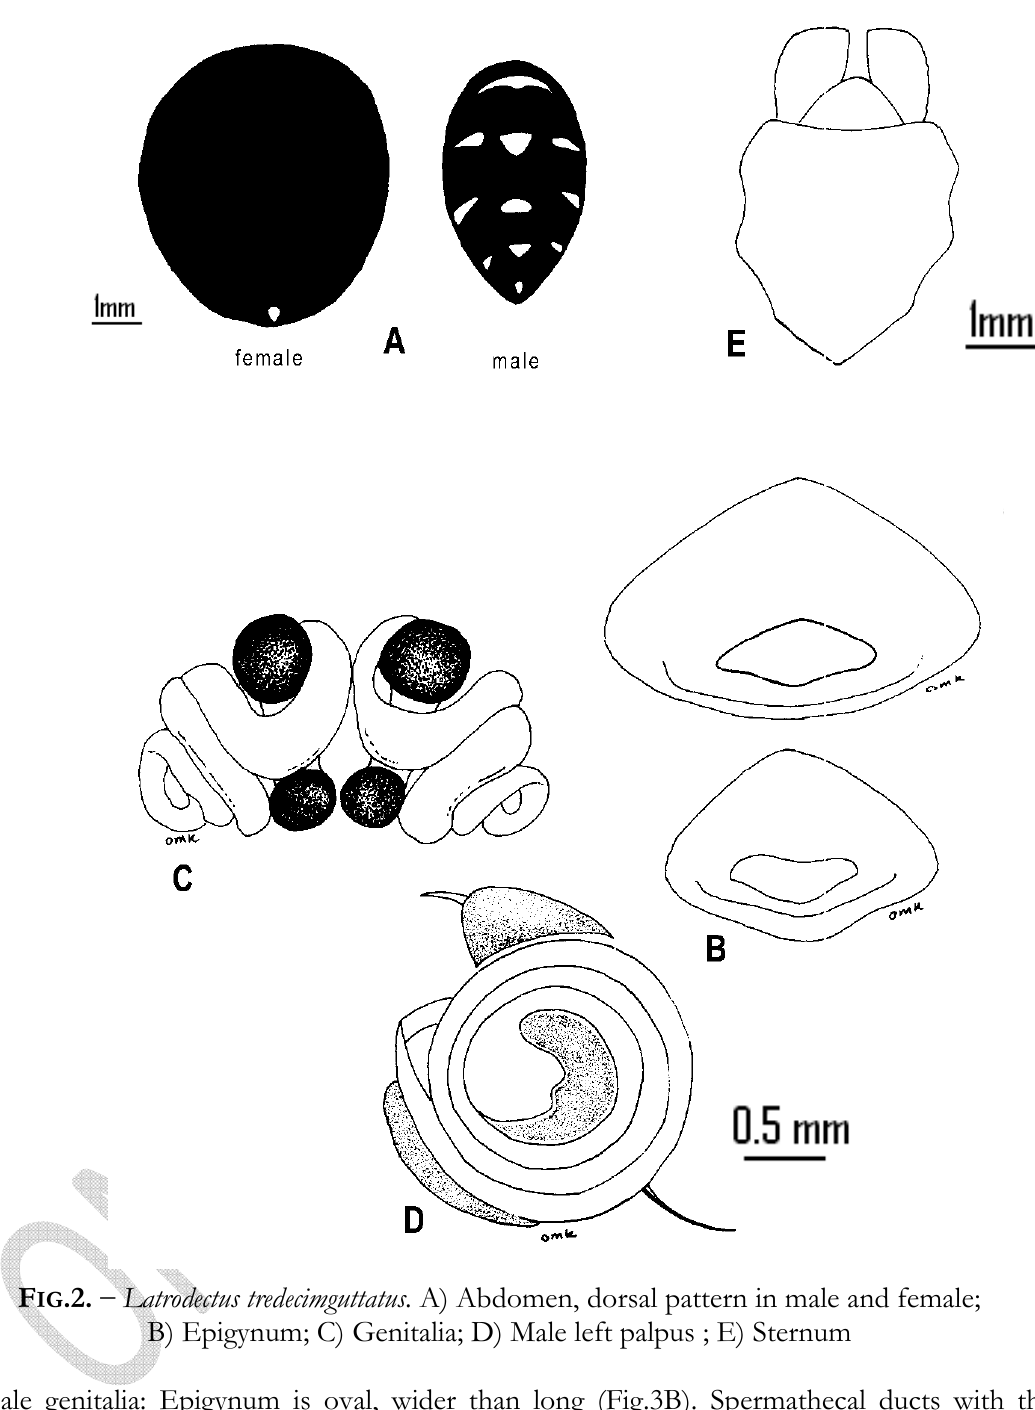
_ F IG .2. Latrodectus tredecimguttatus. A) Abdomen, dorsal pattern in male and female; B) Epigynum; C) Genitalia; D) Male left palpus ; E) Sternum Female genitalia: Epigynum is oval, wider than long (Fig.3B). Spermathecal ducts with three loops